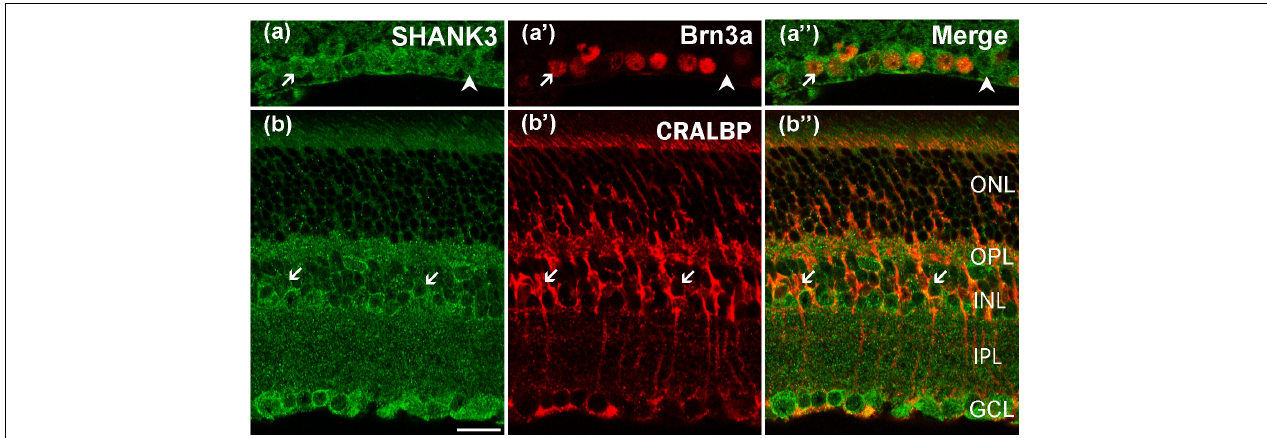
FIGURE 6 | Confocal microphotographs showing the distribution of SHANK3 in GCL and Müller cells. Double staining (green for SHANK3; red for Brn3a and CRALBP) appear yellowish, and arrows indicate some of the double-labeled cells. (a–a”) Colocalization of SHANK3 with Brn3a in a retinal vertical section. Fluorescence double stainings show that SHANK3 (a) and the Brn3a (a’) , (a”) are the merged image of Brn3a and SHANK3. Almost all the ganglion cells are clearly labeled by Brn3a (a’) . SHANK3 immunoreactivity is observed in all Brn3a (arrows). Meanwhile, some SHANK3-positive cells in the GCL are not immunoreactive for Brn3a (arrowheads in a–a” ), which could be displaced ACs or Brn3a-negative GCs. (b–b”) Colocalization of SHANK3 with CRALBP in a retinal vertical section. Fluorescence double stainings show that SHANK3 (b) and the CRALBP (b’,b”) is the merged image of CRALBP and SHANK3. CRALBP is a specific Müller cell marker. Note that SHANK3 immunostaining is observed in somata of CRALBP-positive Müller cells. Scale bar = 20 µ